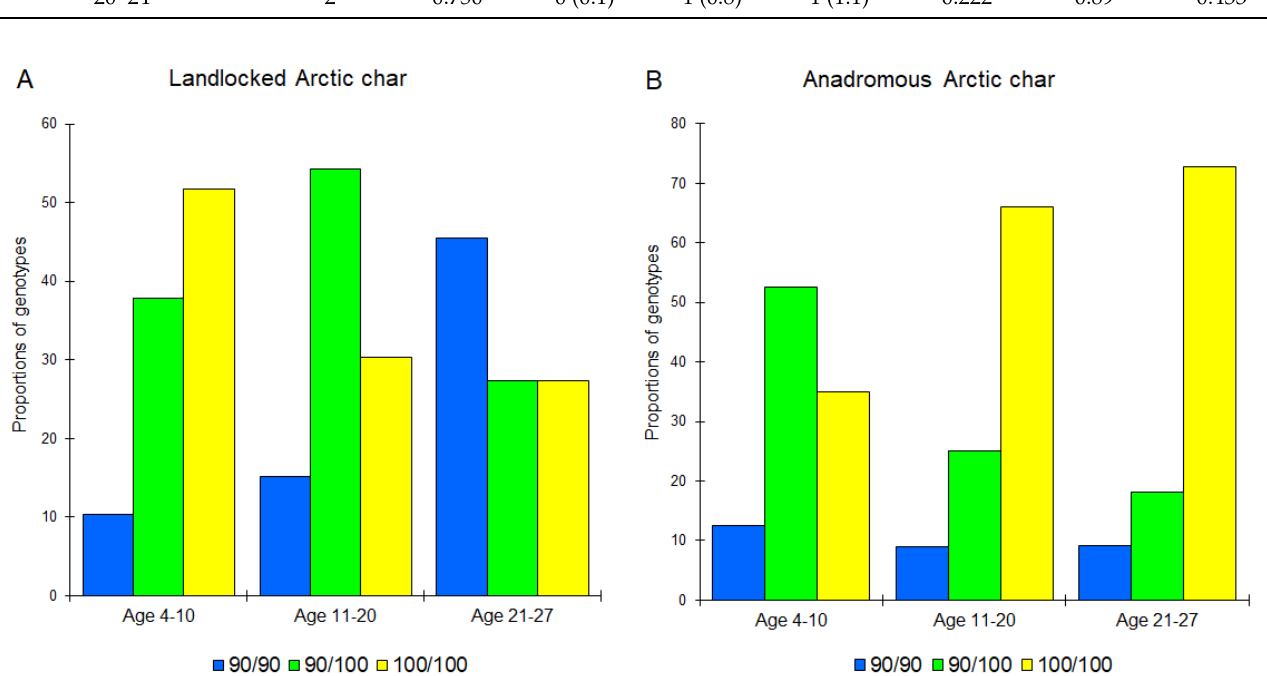
Figure 5. Ontogenetic shifts in the EST-2* genotype dominance in ( A ) landlocked (pooled populations, n = 97) and ( B ) anadromous (Lake Arkvatn, n = 107) Arctic char sampled in Svalbard, 1979– 81.